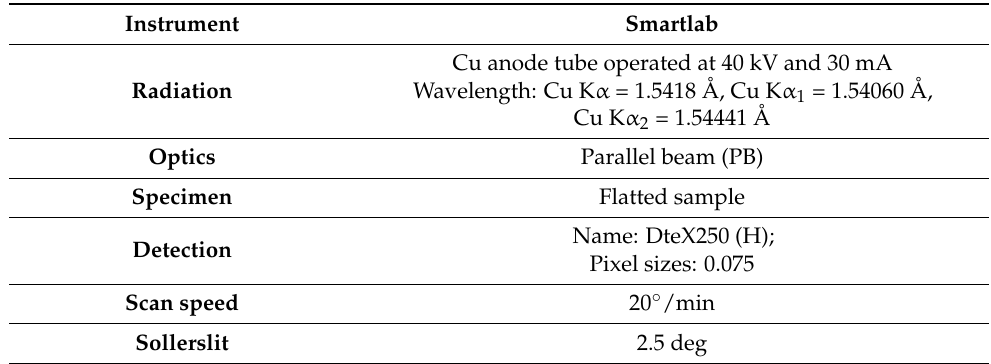
Table 1. XRD profiles measurement